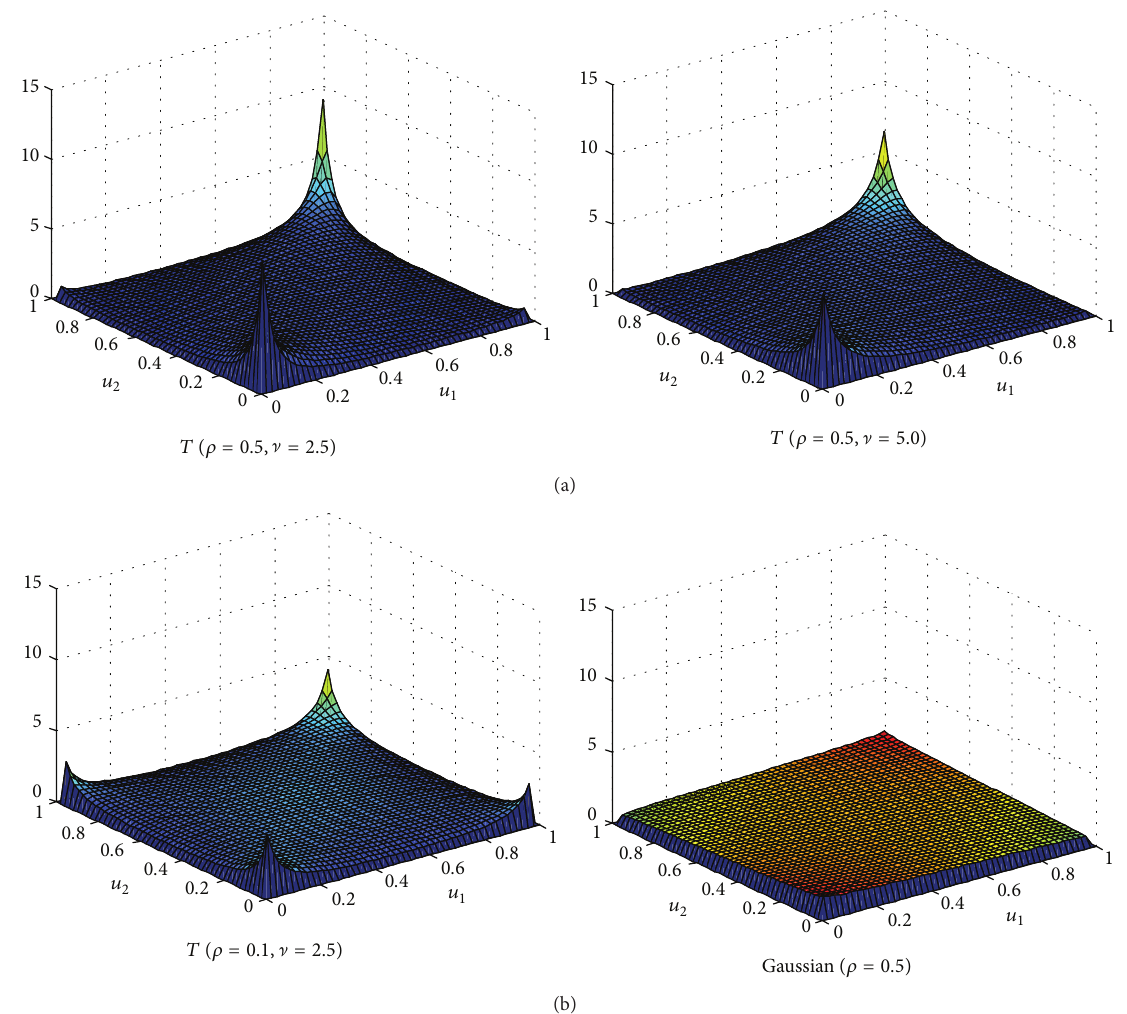
Figure 1: Four detailed pictures of Copula density functions. To visualize their joint probability distributions and dependence structures between variables, this figure shows the surface of the densities for Gaussian and Student’s 𝑇 Copulas with various parameter values. The formulasoftwoCopuladensitiescanbereferredtoCherubinietal.[17].GaussianCopulaonlyhasoneparameter,thecorrelationcoefficient 𝜌 . WhileStudent’s 𝑇 Copulahastwoparameters,thecorrelationcoefficient 𝜌 andthedegreeoffreedom ] ,thelattercontrolstheleveldependence in tails. And when ] approaches infinity, the Student’s 𝑇 Copula would degenerate to Gaussian